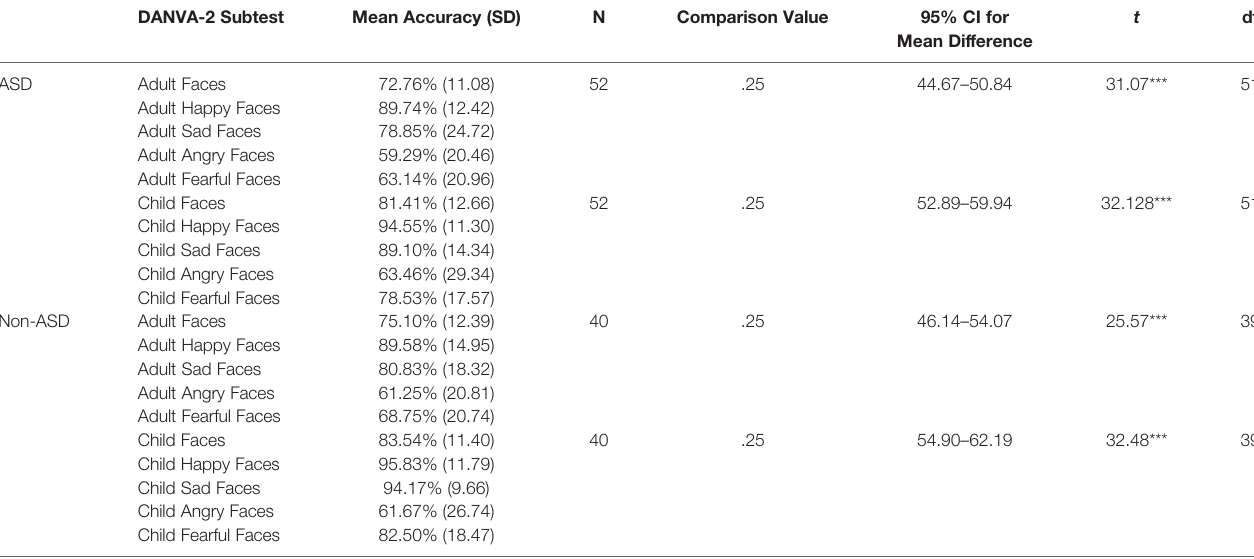
TABLE 2 | Descriptive Statistics and One-Sample t-Tests for Facial Emotion Accuracy on the DANVA-2.